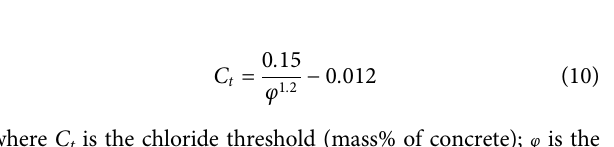
FIGURE 5 | Measured resistivity and porosity (Bediwy and Bassuoni,